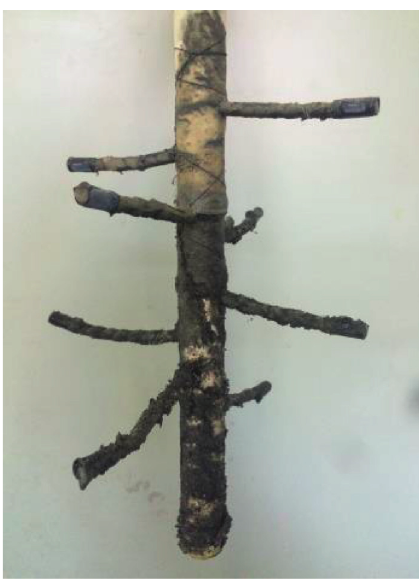
Figure 7: A new type of root-like dehydration tube used after the dehydration test.